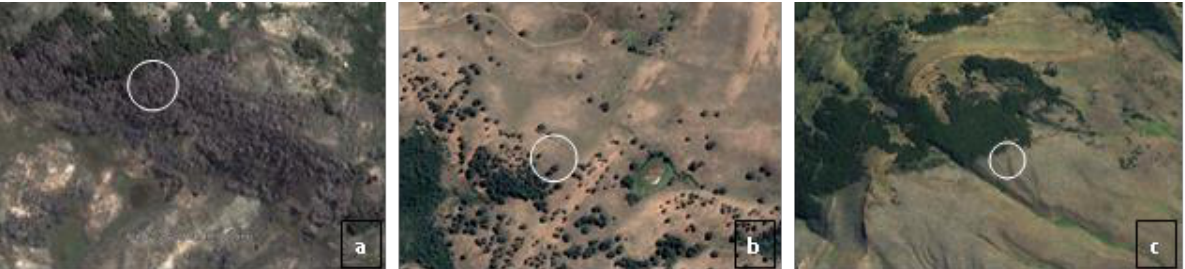
Figure 1. Images of the remnant forest and burned area in ( a ) La Colisión, ( b ) Monte Zeballos and ( c ) Río Turbio, burned in 2008, 1941 and 1980, respectively. The white circles indicate the sampling zones.